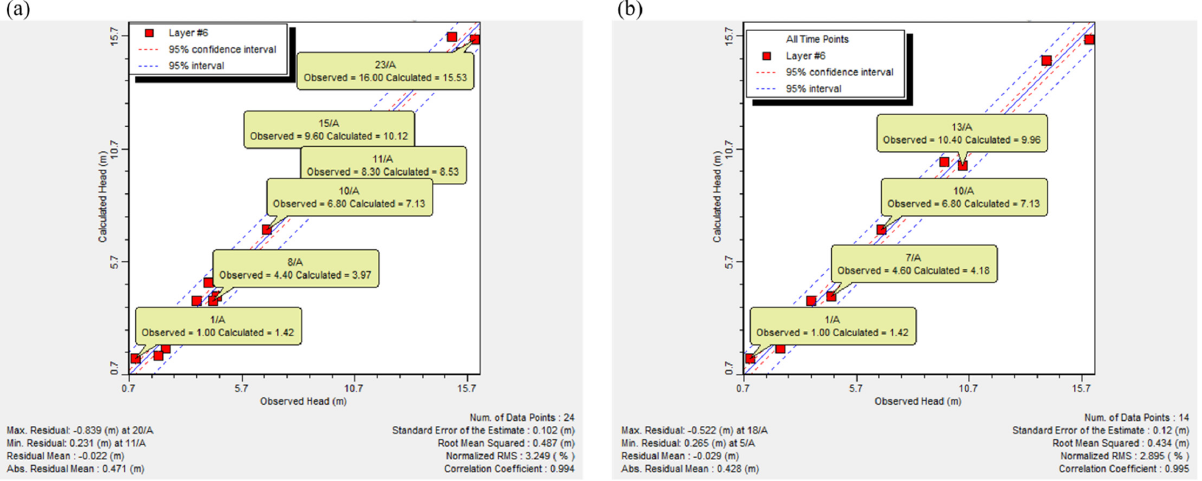
Figure 6. ( a ) Model calibration for calculated and observed heads in m above MSL, ( b ) model verification for calculated and observed heads in m above MSL. Table 3. Result of calibrated hydraulic parameters. Table 2. Result of model calibration for calculated and observed heads.